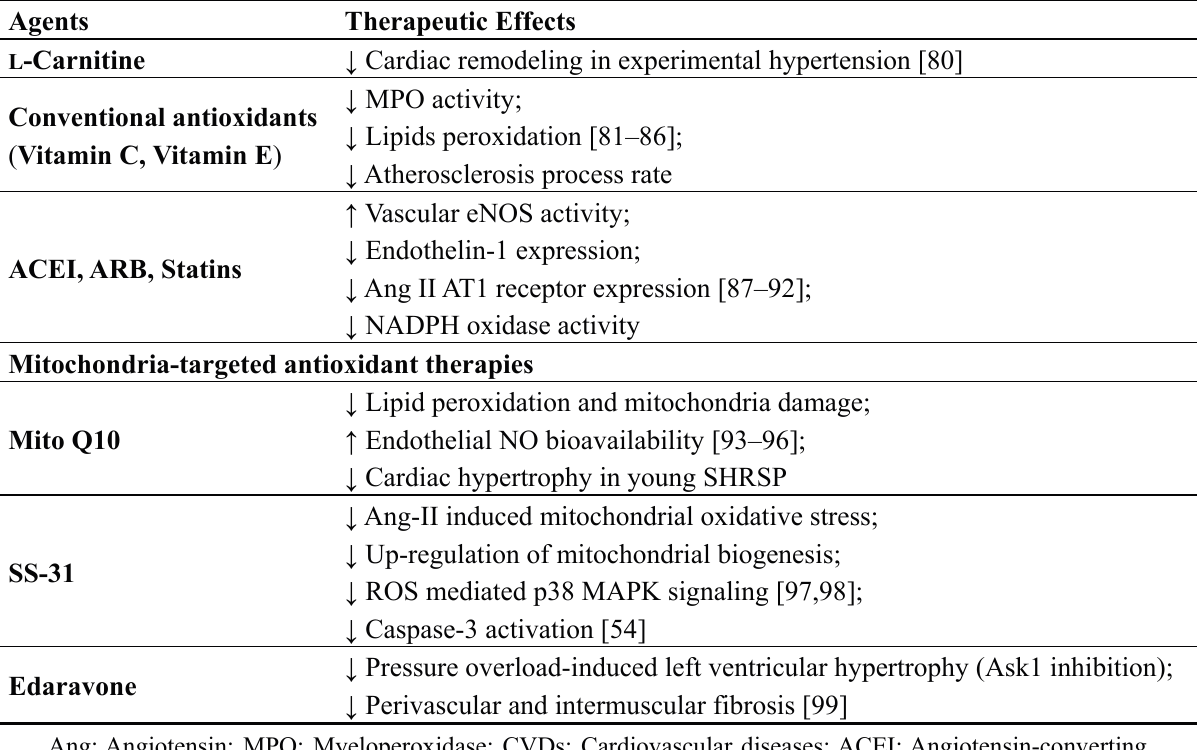
Table 1. Therapeutic